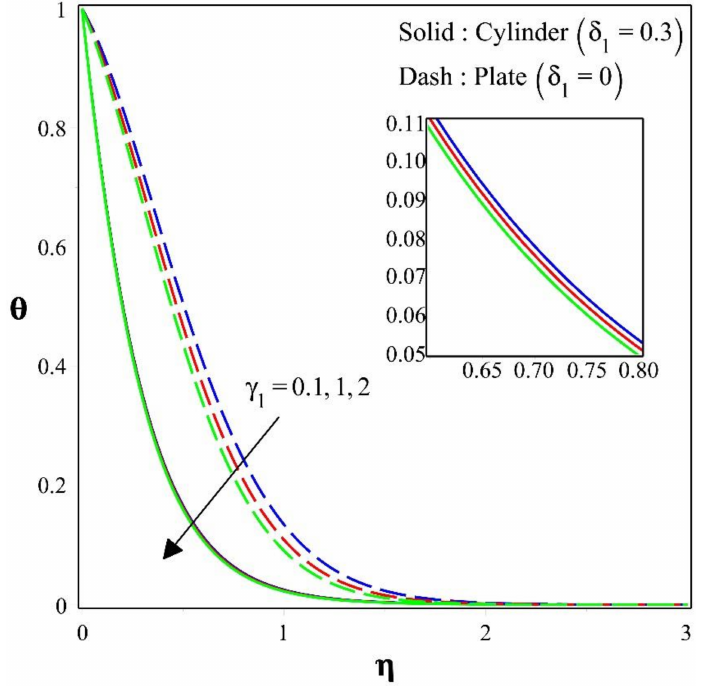
Figure 5. The role of mixed convection parameter on temperature profile (keeping P m = 0.1, ζ = 30 0 , φ 1 = φ 2 = φ 3 = 0.01& H SS =